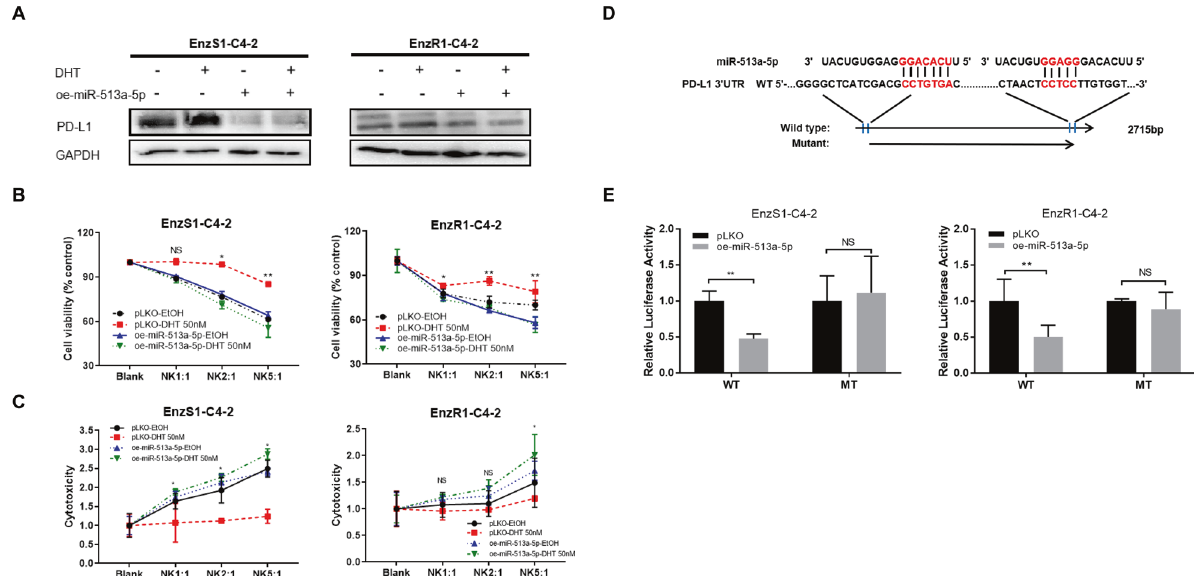
Fig. 6 miR-513a-5p can regulate PD-L1 via binding to the 3 ’ UTR of PD-L1 mRNA. A Western blot of oe-miR-513a-5p in both cell lines showed PD-L1 expression alternation after treatment with 50 nM DHT or EtOH. B , C Before treating EnzS1-C4-2 (left panel) and EnzR1-C4-2 cells (right panel) with 50 nM DHT or EtOH, miR-513a-5p expression was over-expressed. After treatment, MTT ( B ) and LDH C assays were performed separately using NK92-MI cells to target CRPC cells. D Sequence alignment of the PD-L1 3 ’ UTR with wild type (WT) and potential mutant (MT) miR-513a-5p targeting sites. E Luciferase reporter activity after transfection of wild type or mutant PD-L1 3 ’ UTR reporter construct in EnzS1-C4-2 (left panel) and EnzR1-C4-2 cells (right panel) with/without oe-miR-149-3p.* p < 0.05 ** p < 0.0, NS Not Signi fi (Fig. 6D). As expected, the luciferase assay results revealed that overexpressing miR-513a-5p markedly decreased luciferase activ- ity in EnzS1-C4-2 and EnzR1-C4-2 cells transfected with wild type (WT) PD-L1 3 ’ UTR but not the mutant (MT) PD-L1 3 ’ UTR (Fig. 6E). Together, results from Fig. 6A – E suggest that a high dose DHT/AR/ circFKBP5/miR-513a-5p axis can increase the PD-L1 expression via circFKBP5 sponging miR-513a-5p binding to the 3 ’ UTR of PD- L1 mRNA.